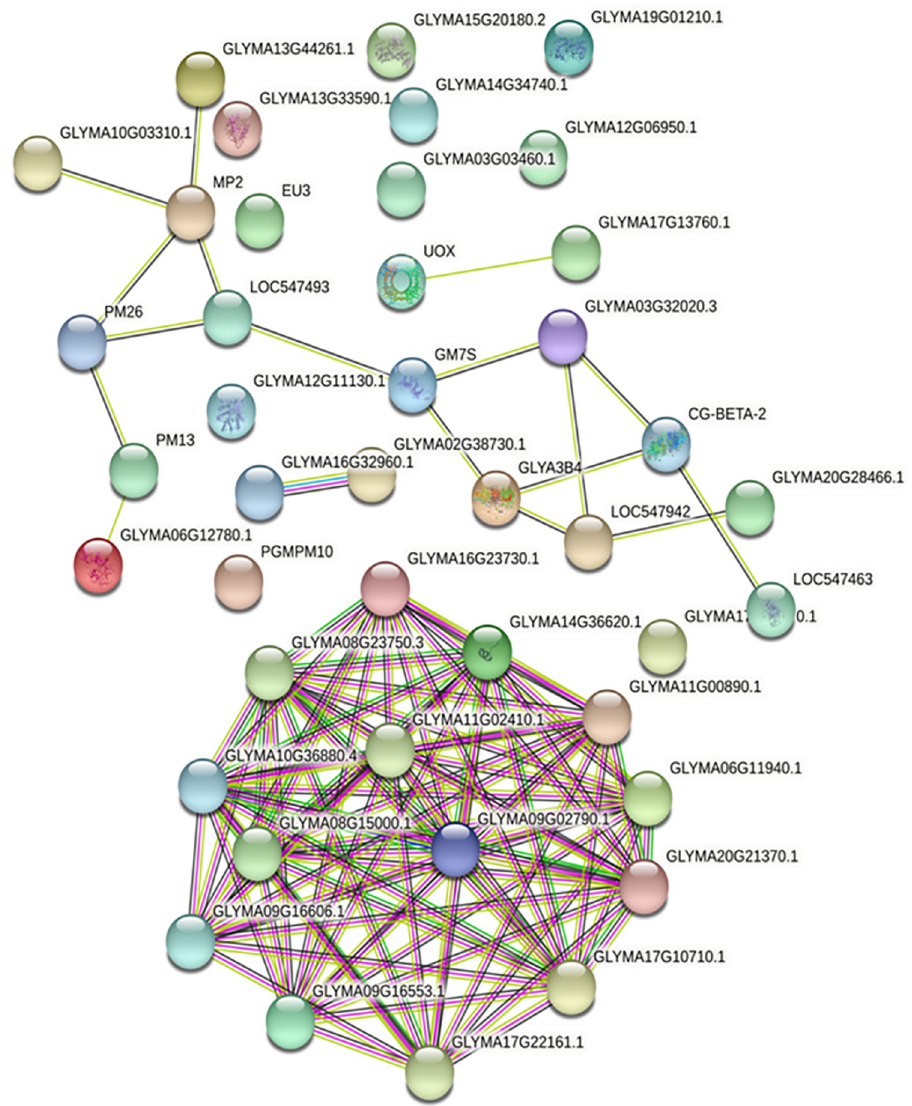
Fig 5. Protein-protein interactions network among the differentially changed proteins analyzed through